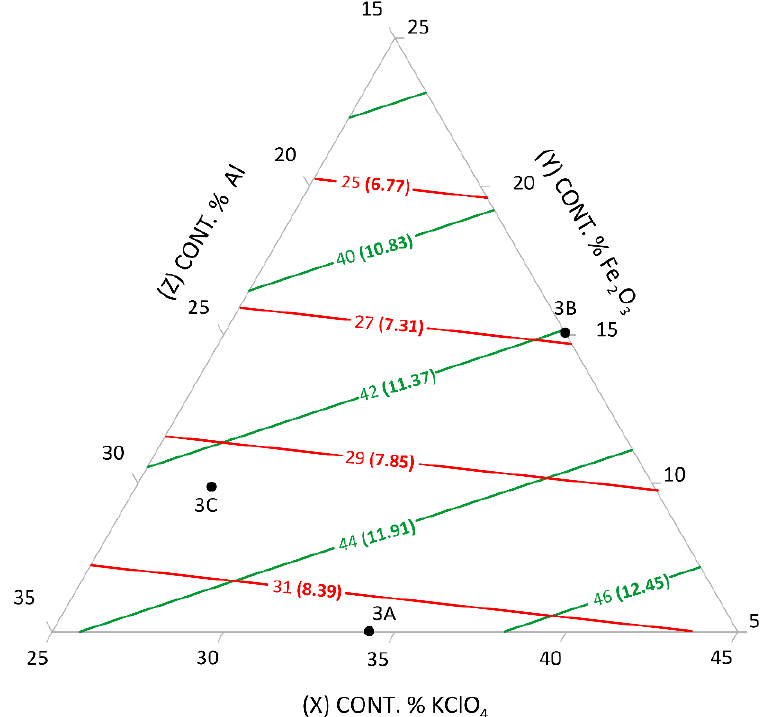
Figure 3. Relationship between costs of the composition (USD/kg): red line—1981, green line—2021; and the content of pyrotechnic composition components (%). Sides of the triangle, with fixed sulphur content S = 35%.